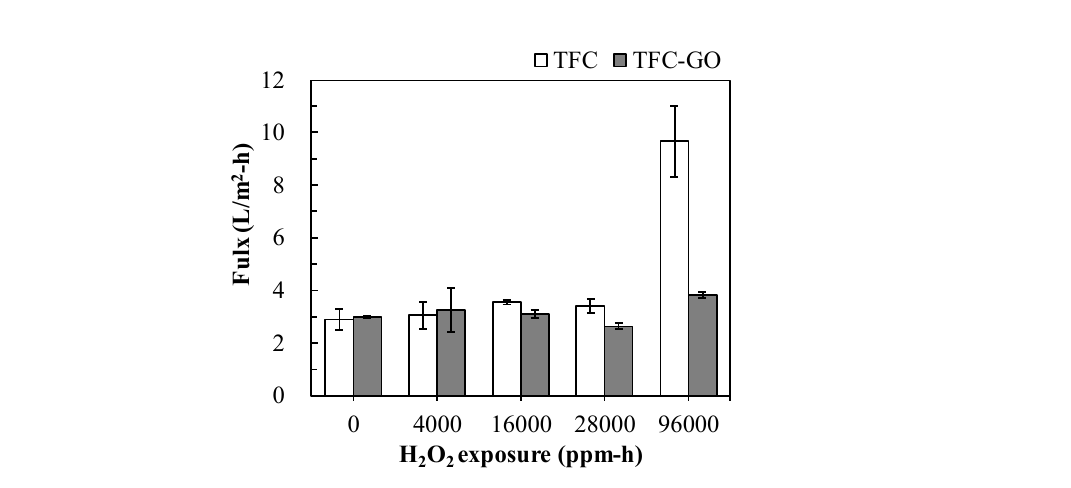
Figure 5. Permeate flux of TFC and TFC-GO membranes with the range of 0 − 28,000 ppm-h H 2 O 2 exposure. Error bars represent one standard deviation of triplicate measurements.